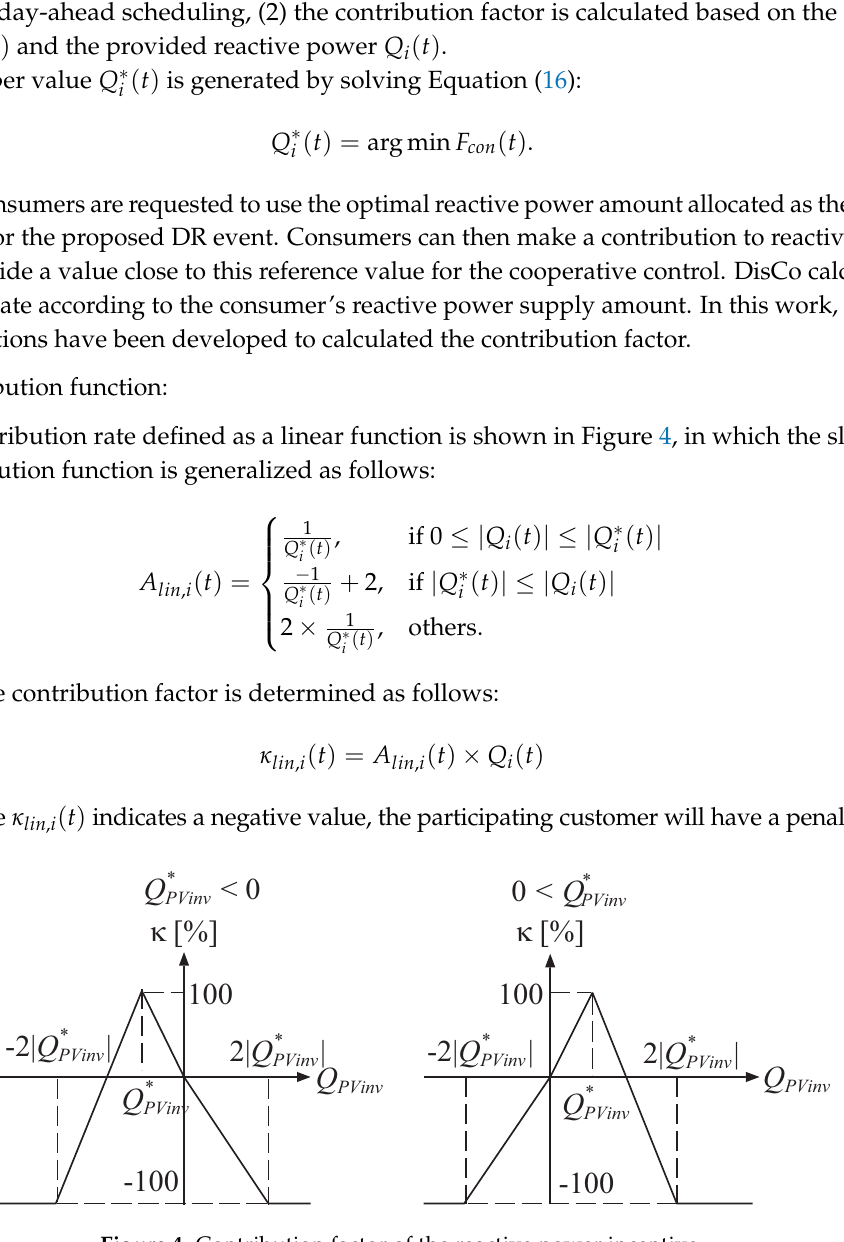
Figure 4. Contribution factor of the reactive power